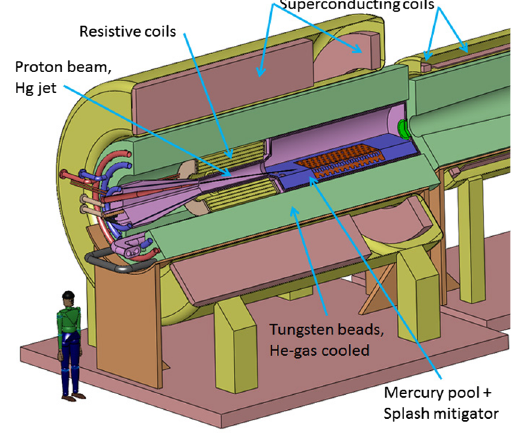
axis.FIG. 3. Neutrino factory/muon collider target